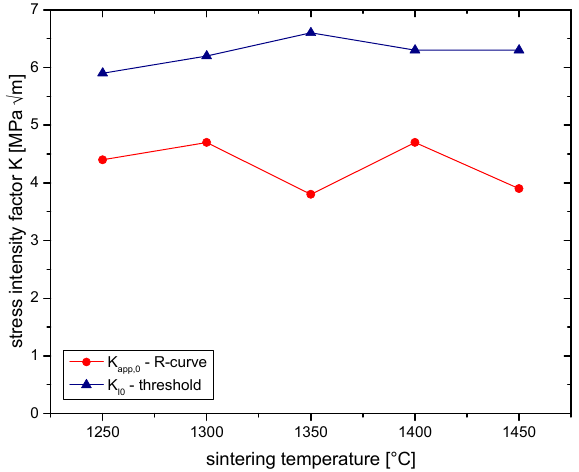
Figure 4. Stress intensity values K app,0 and K I0 of 2Y-TZP determined by SIGB test.